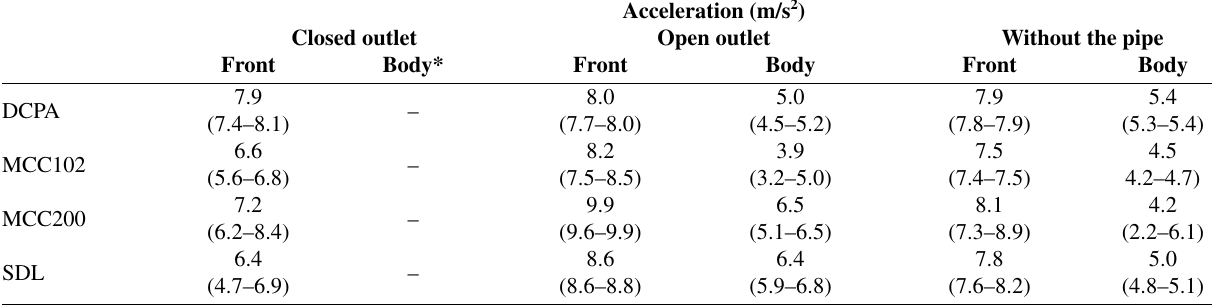
Table 3. Acceleration of the powder plug front and body for closed and open outlet conditions, and the condition without the pipe for all tested ma- terials: dicalcium phosphate anhydrous (DCPA), microcrystalline cellulose MCC102 and MCC200, and spray-dried lactose (SDL).